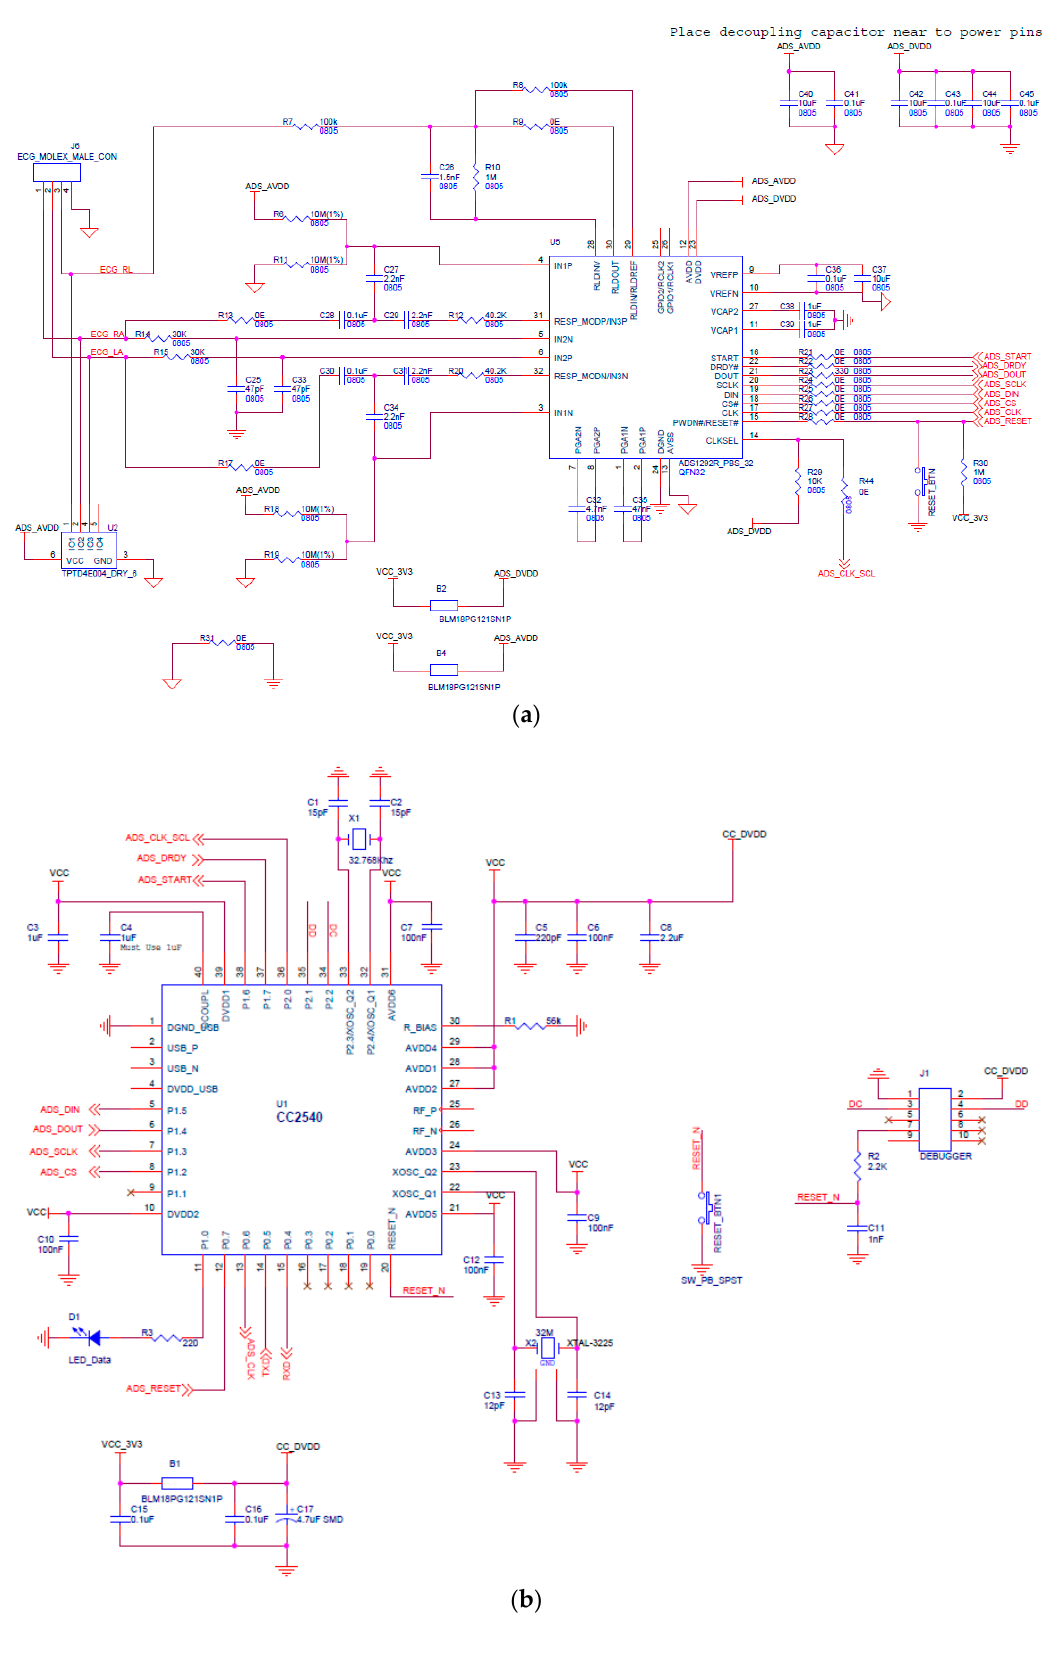
Figure 3. Schematic diagrams: ( a ) wearable platform with wireless MCU; ( b ) CC2540F256.